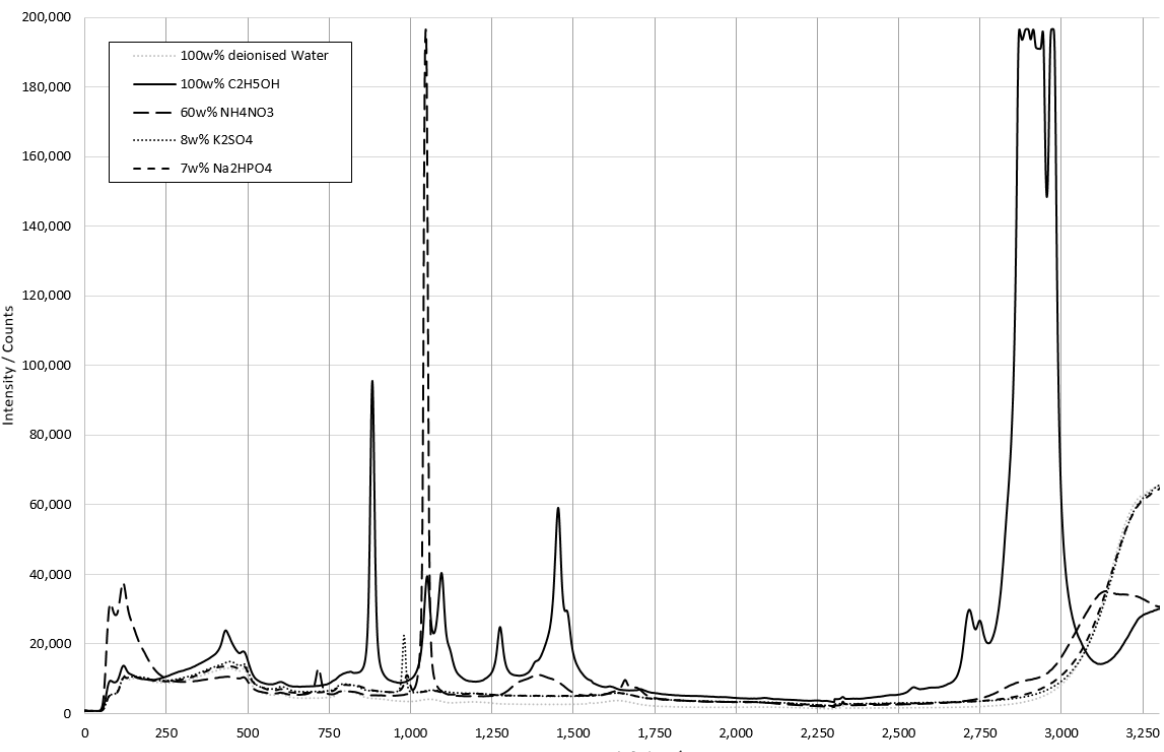
Figure 4. Raw spectra of ammonium nitrate, di-sodium hydrogen phosphate, potassium sulphate, and ethanol with the maximum concentration dissolved in deionized water. Integration time 10 s, spectra accumulation 3. Table 1. Raman band assignment of the individual substances below a Raman shift of 1500 cm − 1